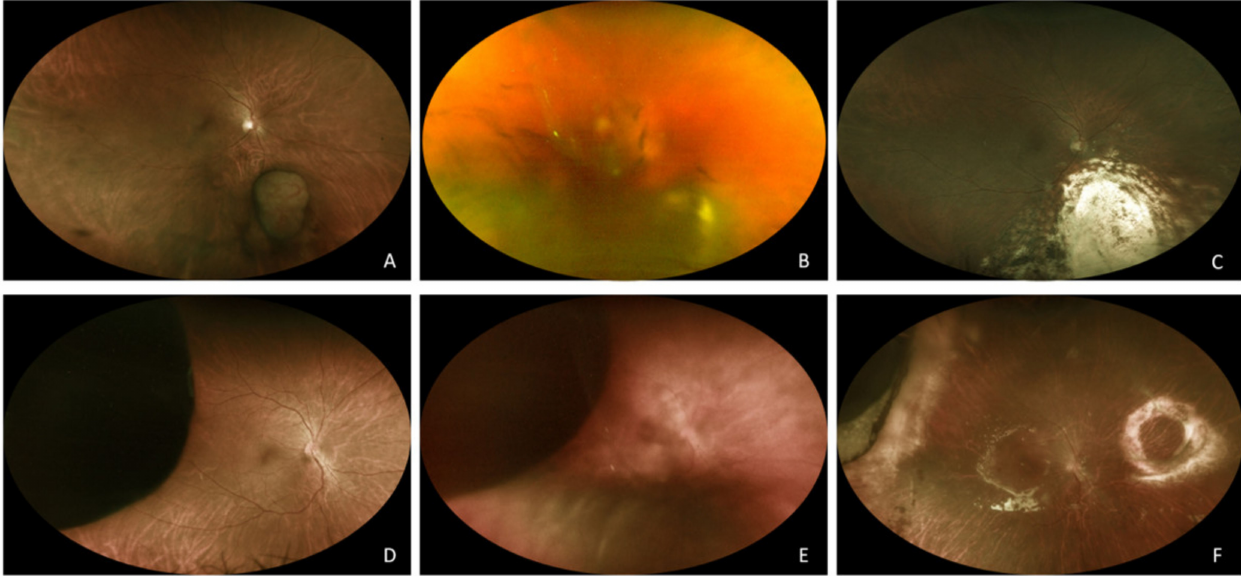
Figure 1. Endoresection . ( A ). Mushroom-shaped choroidal melanoma in the only eye with functional BCVA of an amblyopic patient at baseline. ( B ). Vitreous haemorrhage 6 months after PBT. ( C ). Surgical coloboma 3 years after PBT and 2.5 years after endoresection with final BCVA of 6/6. Endodrainage . ( D ). Large cilio-choroidal melanoma at baseline. ( E ). Macula off exudative retinal detachment 5 months after PBT. ( F) . Tumour regression with attached retina under silicone oil 1 year after